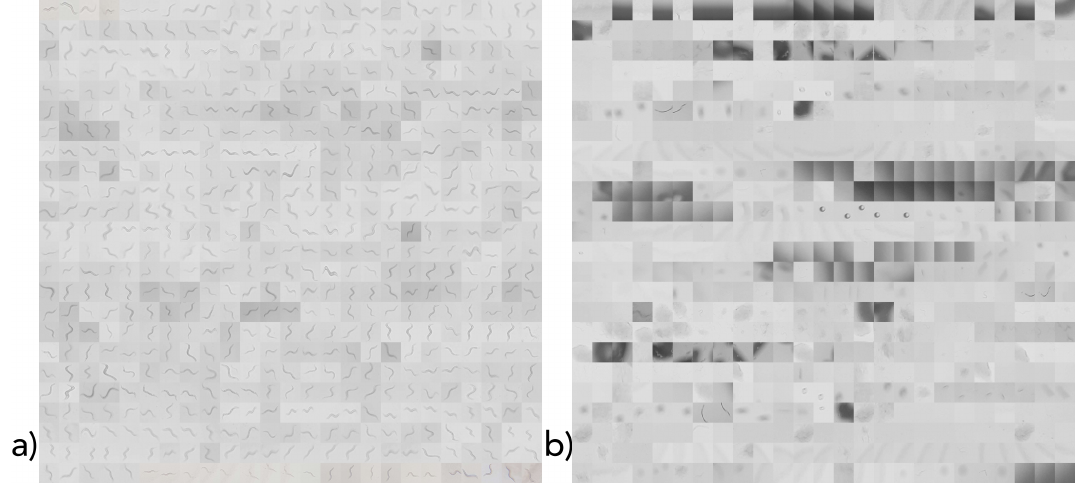
Figure 7. Resulting datasets of C. elegans covering ( a ) positive and ( b ) negative samples.